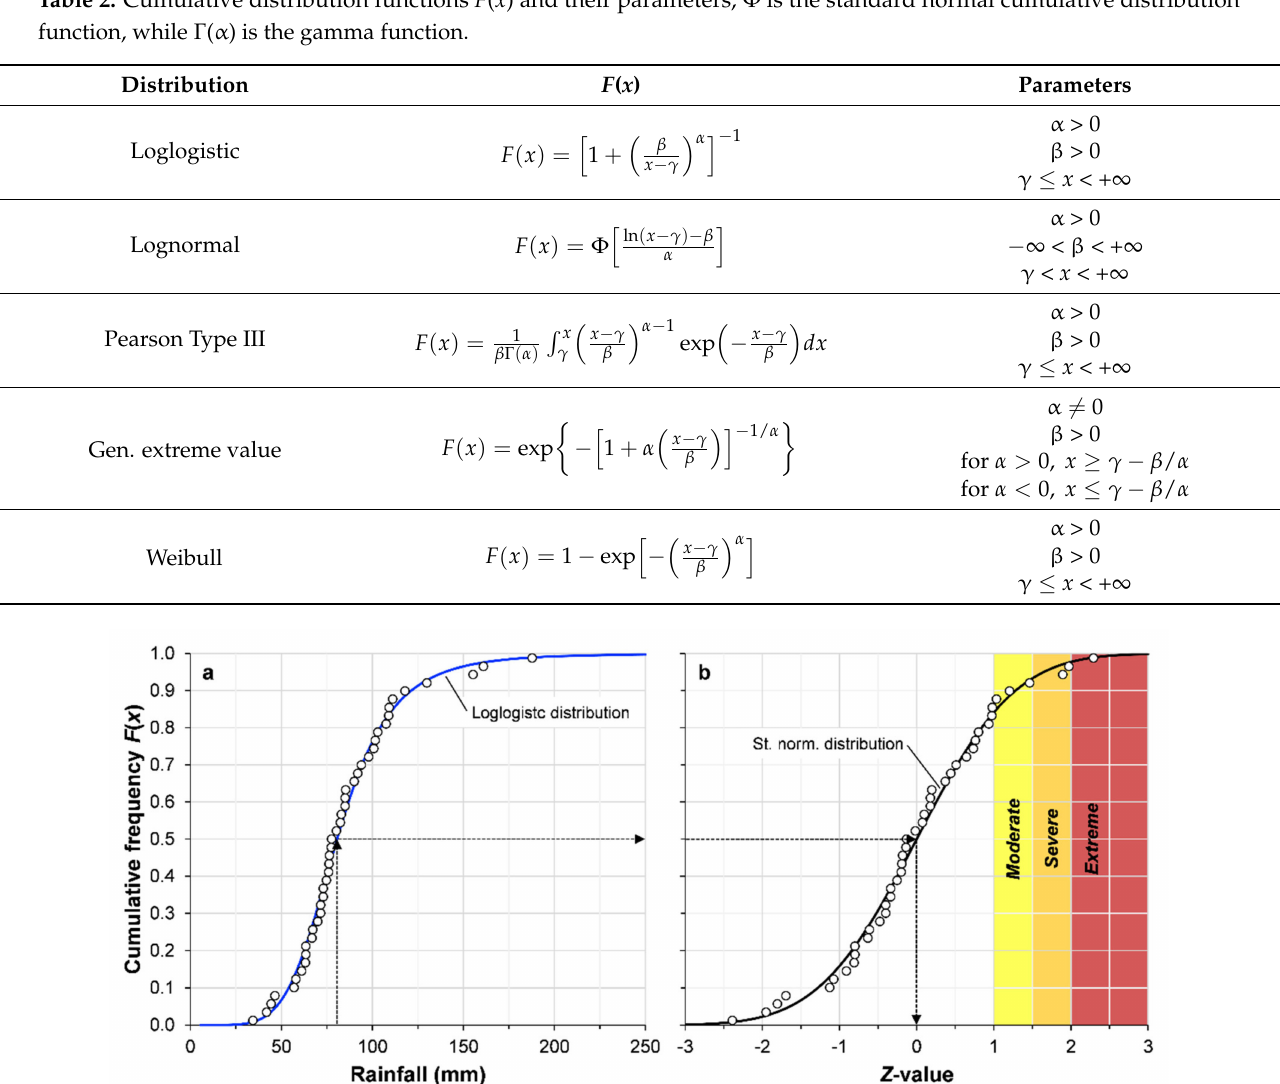
Figure 5. ( a ) Transformation of the best-fitting distribution (three-parameter loglogistic distribution) into ( b ) a standard normal distribution. Actual data (white circles) are plotted by using the Gringorten formula [26]. The magnitudes of the rainstorms falling in the upper-tail part of the distributions (positive Z-values) are described by colors, where an event can be classified as moderate (1 ≤ Z < 1.5), severe (1.5 ≤ Z < 2) or extreme (Z ≥